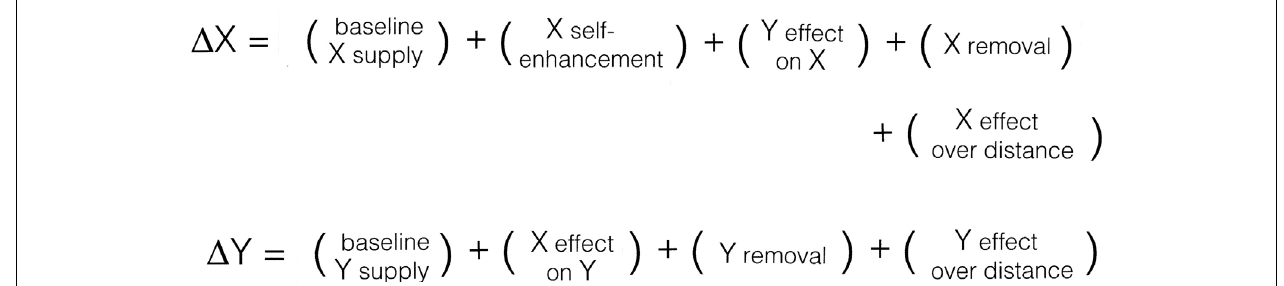
FIGURE 2 | The components needed by Turing’s mechanism to form patterns, expressed formally here as changes over time (the deltas) of two variables (X and Y) depending on their supply, removal, and the interactions in which they participate. One then has to find an appropriate way for each of these processes to be expressed mathematically, and some of the plus signs will (indeed, must) become minus signs. In this analysis, the model is taken to represent a developmental process, with the Xs and Ys interpreted as structural in nature (see text for details), so the emergence of a “pattern” reflects changes to the way neural circuitry is locally ordered in three-dimensional space during brain development. Consciousness enters only because of the way the variables are interpreted, in this case by supposing that X-dependent synaptic reordering affects subjective experience in some way, but without specifying how. The model can then be used to address questions about the emergence during development of structural features capable of evoking or otherwise affecting conscious experience, but says nothing about the nature or origin of experience